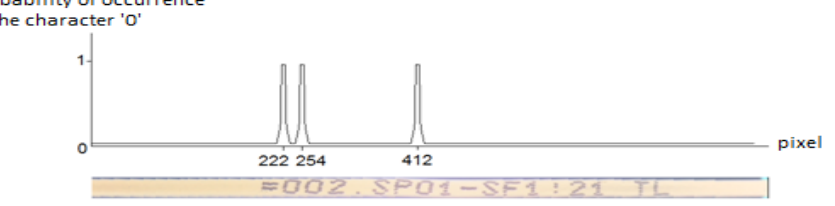
Figure 14. Sample of “zero” character recognition during identification of wire marking by using a DCNN.